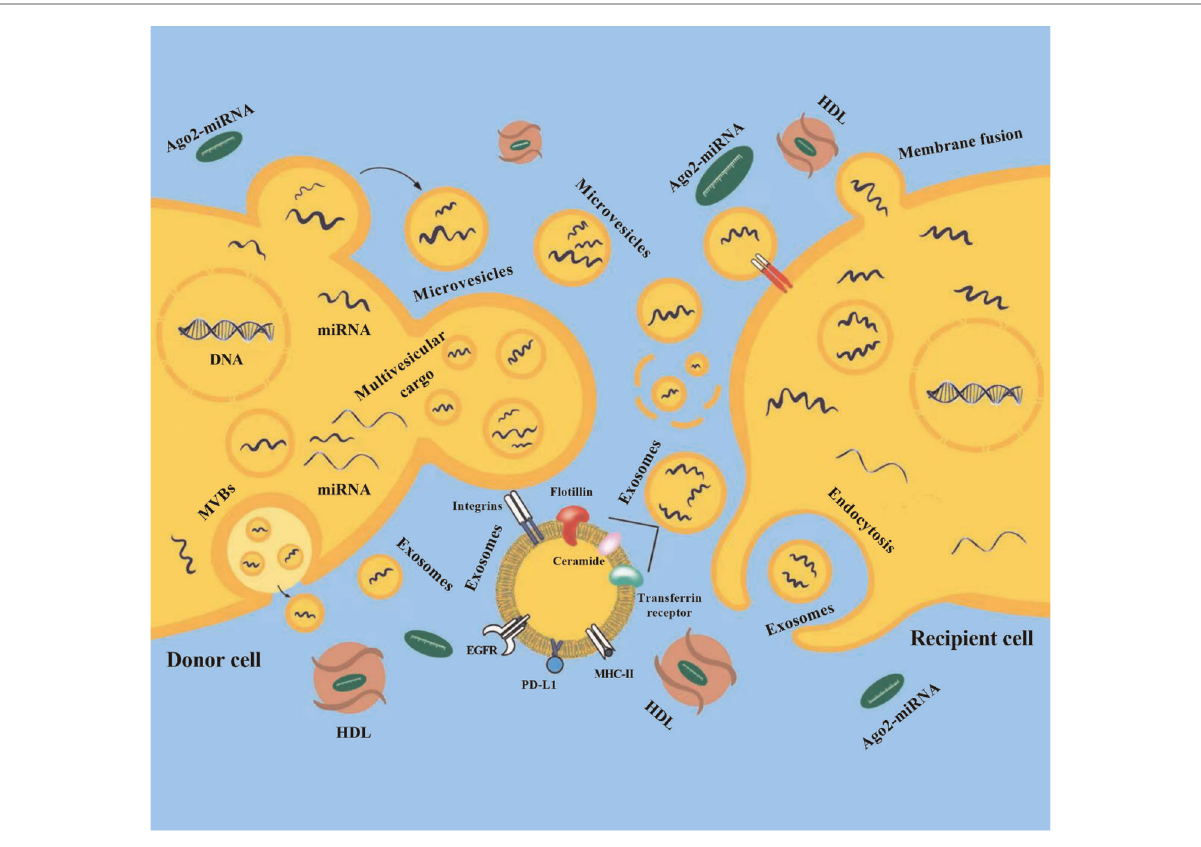
FIGURE 1 Release of microRNAs (miRNAs) into the extracellular environment. Released miRNAs are transported by extracellular vesicles (EVs) and transferred to recipient cells (from donor cells) where they regulate post-transcriptional gene expression. Membrane exosomes are released from cells as endosomes containing multivesicular bodies (MVBs) that fuse with the plasma membrane. Microvesicles (MVs) are released from the plasma membrane via outward budding. Multivesicular cargo (MVC) is released by membrane budding during apocrine secretion. EVs and their miRNAs cargo are transferred to recipient cells (from donor cells) after endocytosis or membrane fusion. MiRNAs can also be secreted outside of vesicles. Most circulating miRNAs are in a non-vesicular form, namely, they are associated with Ago2 proteins (Ago2-miRNA complex). In addition to the Ago2 protein, high-density lipoproteins (HDL) are reported to be involved in the mechanism of intercellular communication and are involved in the transport and delivery of miRNAs. EGFR, epidermal growth factor receptor; PD-L1, programmed death-ligand 1; MHC-II, major histocompatibility complex class